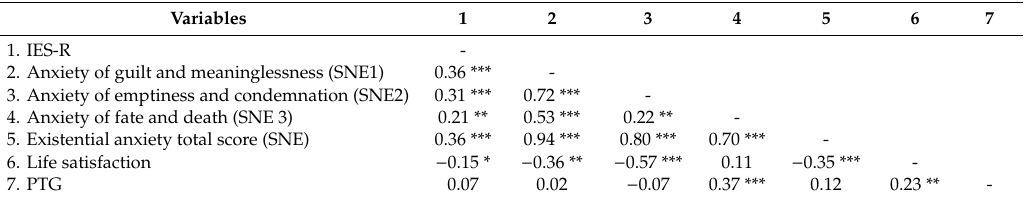
Table 4. Pearson’s correlation